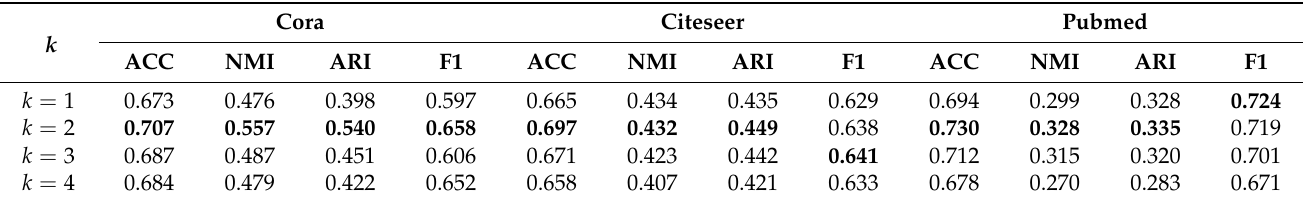
Table 6. Differences in the accuracy of node clustering with different neighbor orders.